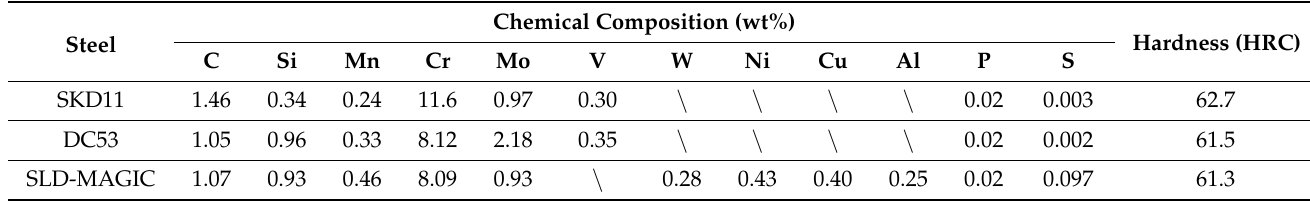
Table 1. Chemical composition and hardness of tool steels used in the study.